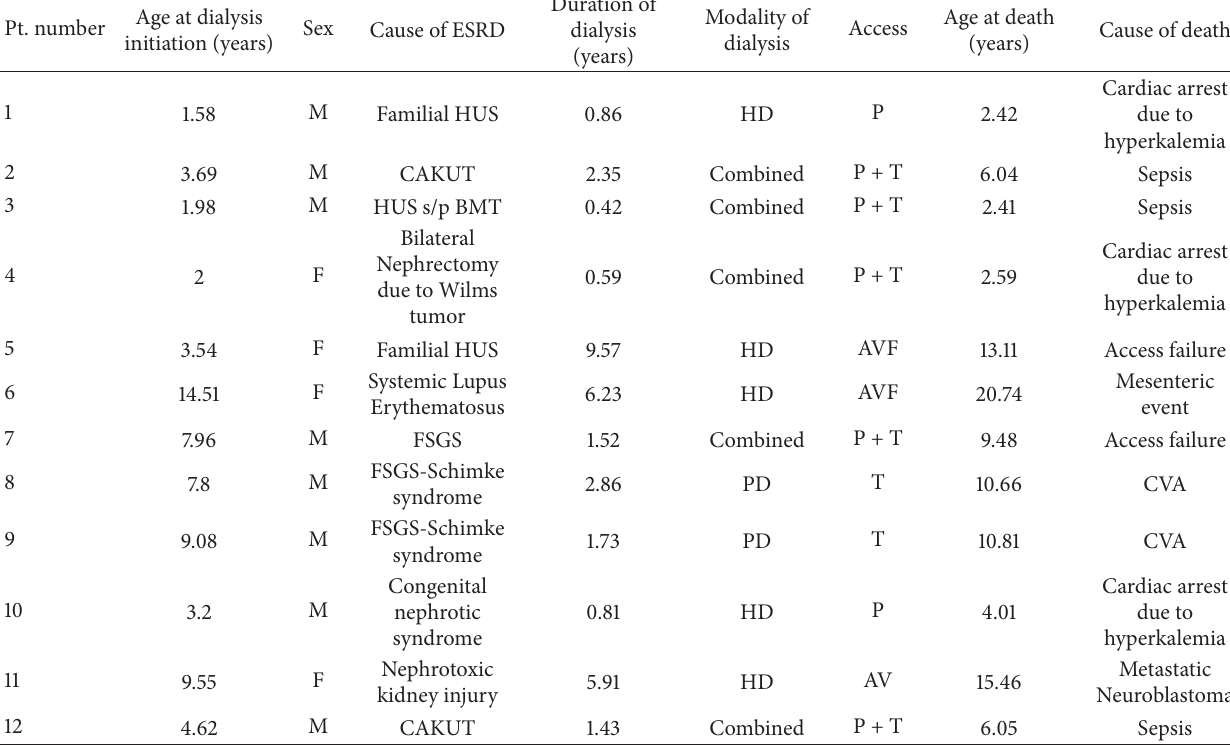
Table 3: Characteristics of patients on maintenance dialysis who died during the study period (12/110). Pt.